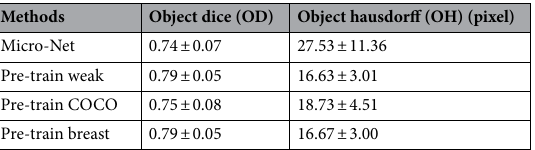
Table 4. Validation results for M-test dataset using training sample size of 72 ROIs.